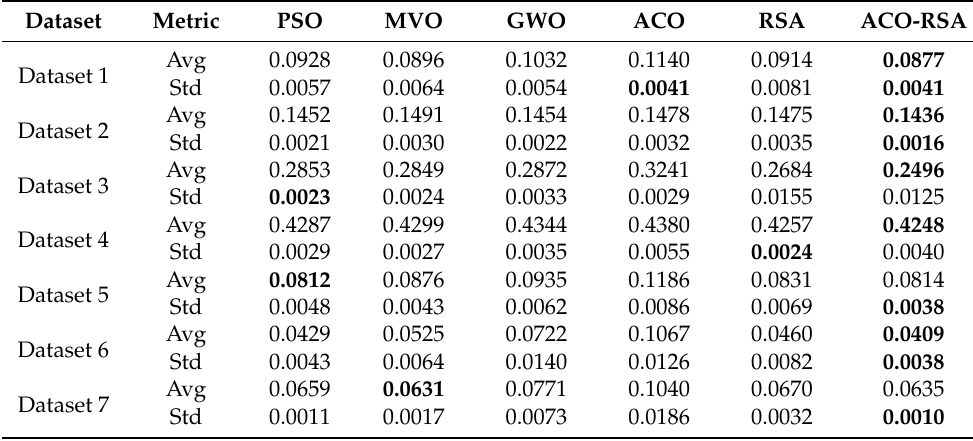
Table 5. The Avg and Std of fitness values of the ACO-RSA and the other